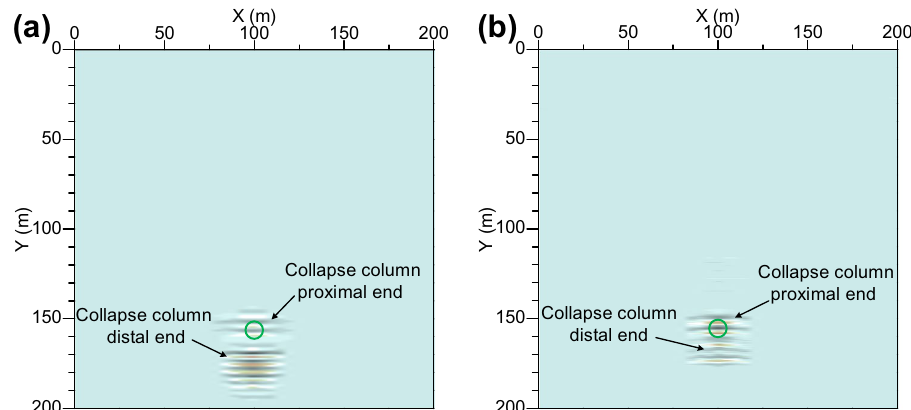
Fig. 12 Depth profiles of the working face 3D model: a P -wave, b Rayleigh channel wave